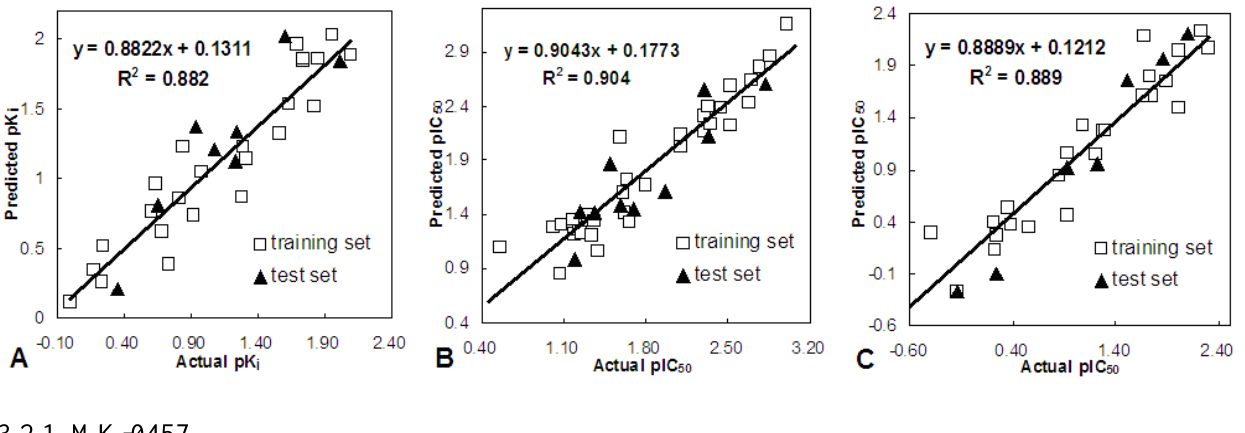
Figure 1. The correlation plots of predicted versus actual Aurora B inhibitory activities using the training (white squares) and test (black triangles) sets based on ( A ) CoMSIA model of MK-0457; ( B ) CoMSIA model of GSK1070916 and ( C ) CoMSIA model of SNS-314. The solid lines are the regression lines for the fitted and predicted bioactivities of training and test compounds in each class,